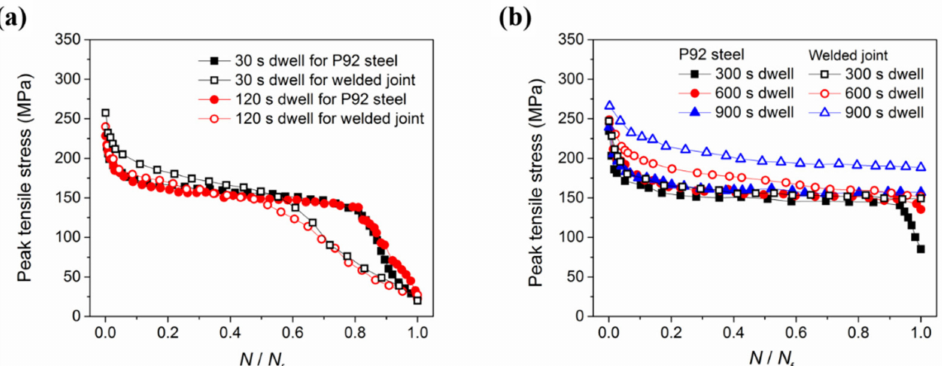
Figure 5. Variations in measured peak tensile stress during the creep-fatigue test with ( a ) short holding times (30 and 120 s) and ( b ) long holding times (300, 600 and 900